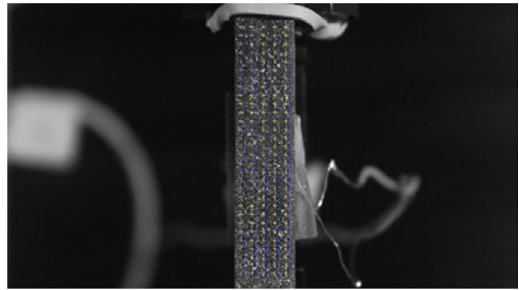
Figure 5. Rectangular grid 30x5 applied on the speckle to determine the longitudinal and transverse deformation.